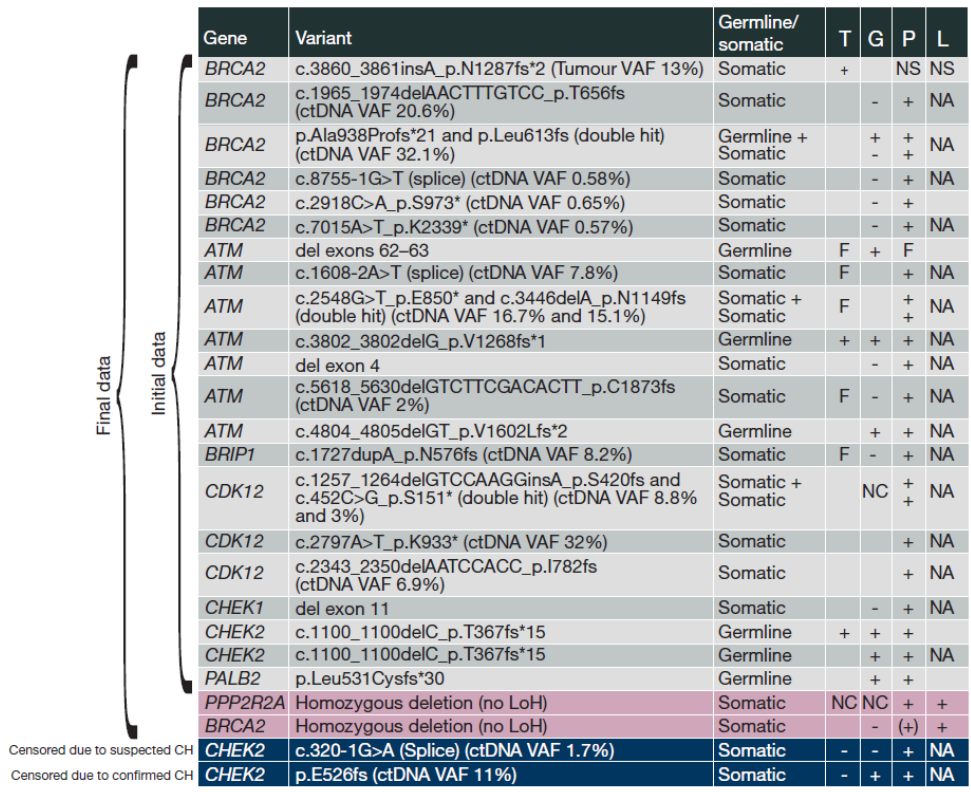
Figure 3. Summary of HRRm variants detected across all test modalities. One row per patient. VAF is shown for somatic variants (detected in tumour or ctDNA, and confirmed not present in germline, OR suspected somatic based on observed VAF). (CH, clonal haematopoiesis; ctDNA, circulating tumour DNA; F, test fail; G, germline test; HRRm, homologous recombination repair mutation; L, plasma low-pass whole genome; NA, not applicable (variant not detectable by technique); NC, gene not covered; NS, non-shedder; P, plasma-targeted next-generation sequencing test; T, tumour tissue test; VAF, variant allele frequency; +, mutation detected; – , mutation not detected; (+), mutation detected upon manual review of data based on signal in low-pass whole genome; Blank, no sample).